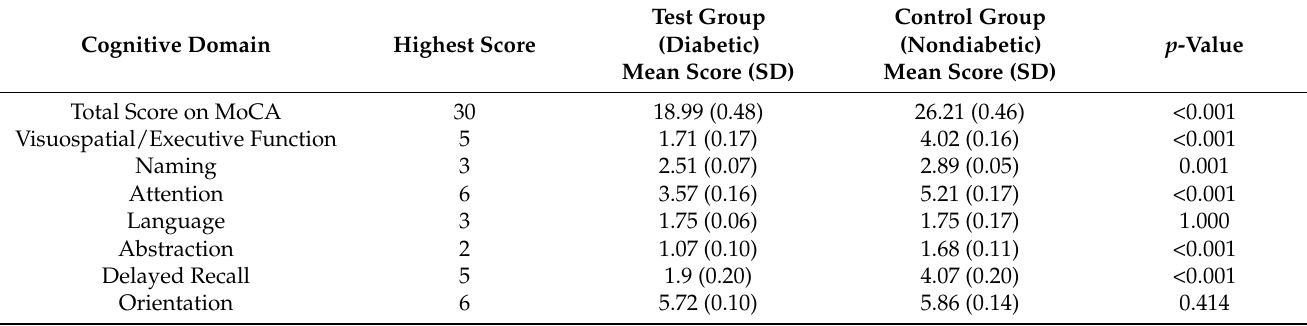
Table 2. Mean MoCA score in the test and control groups for total cognitive function and each